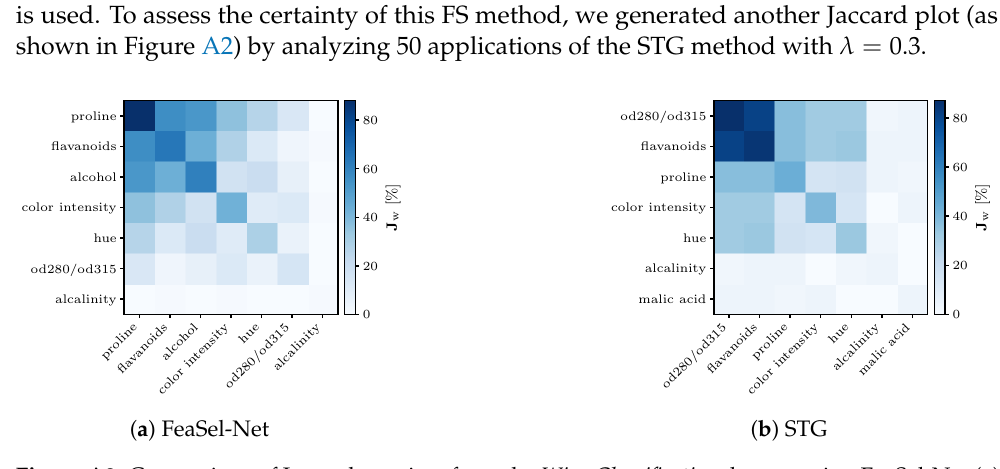
Figure A2. Comparison of Jaccard matrices from the Wine Classification dataset using FeaSel-Net ( a ) and stochastic gates ( b